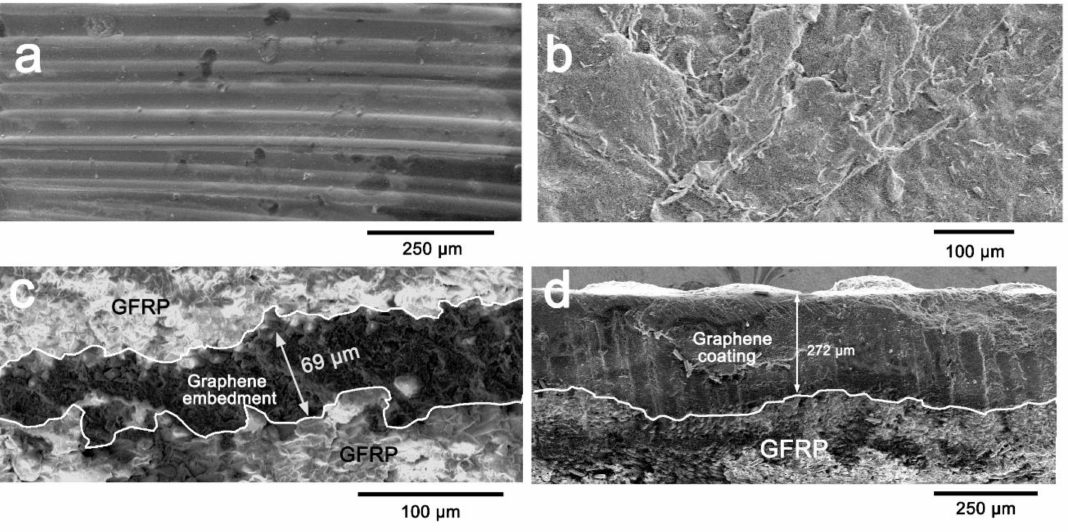
Figure 3. Representative SEM images of GFRP composite laminate with graphene preparation: ( a , b ) Surface morphology and ( c , d ) cross-sections of samples with graphene embedded in interlayer ( a , c ) and coating ( b , d